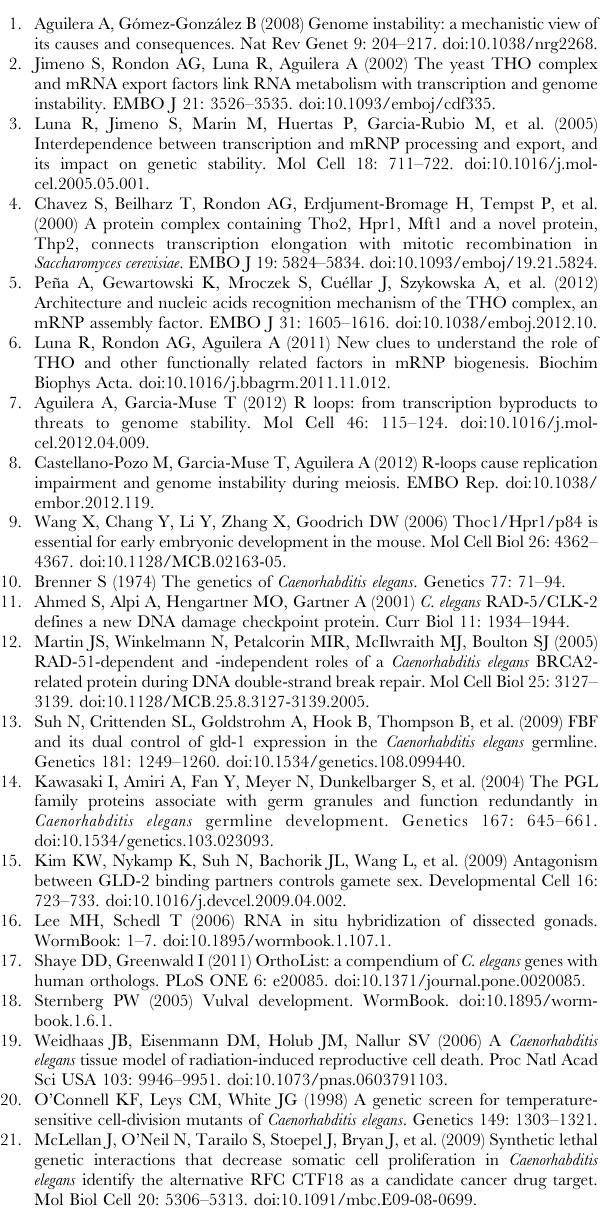
Table S1 C. elegans THO complex comparison with mammalian THO complex